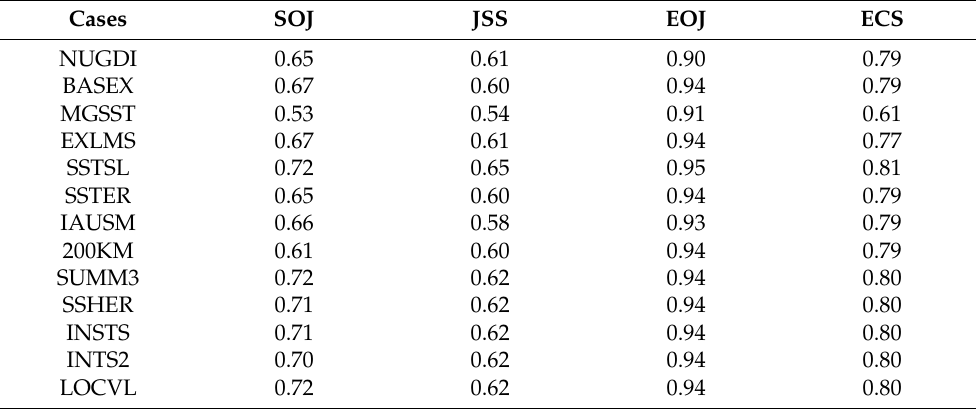
Table 2. Minimum values of regionally calculated daily correlation between modeled and observed SST ( SST o ) data for the period from 1 July to 31 August 2020. Locations of the target regions (SOJ: south of Japan, JSS: Japan Sea south, EOJ: east of Japan, ECS: East China Sea) are shown in Figure 1.